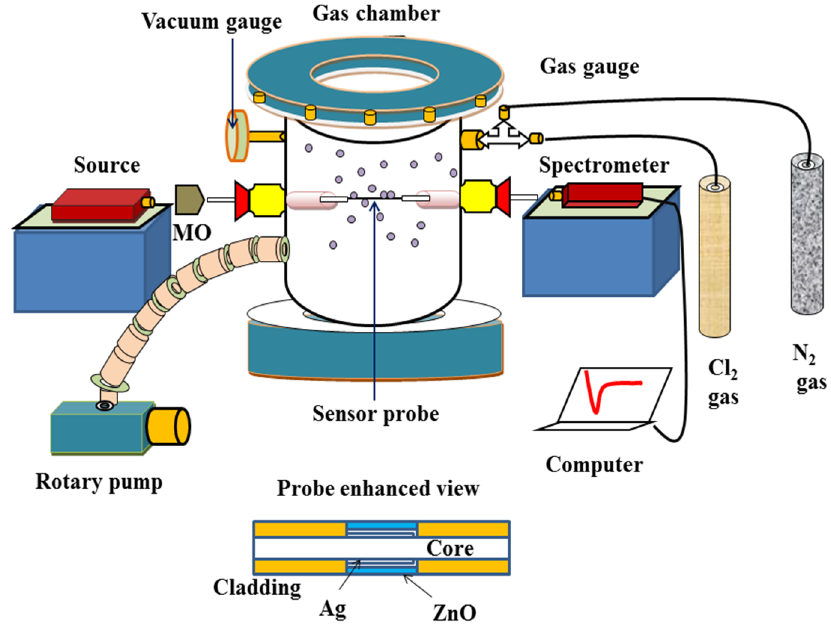
Figure 2. Schematic of experimental chlorine gas sensing set